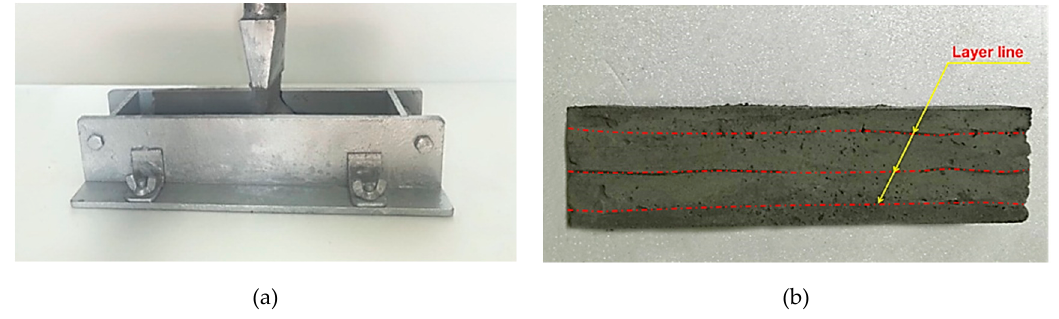
Figure 1. Preparation of the printed specimens: ( a ) Specimen production using 3DAC process; ( b ) Produced specimen using 3DAC process.